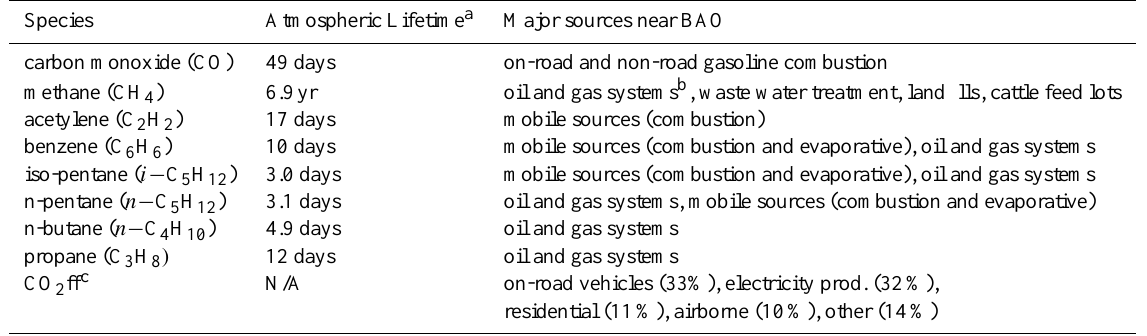
Table 2. Summary of trace gas lifetimes and major emission sources influencing observations at BAO (Watson et al., 2001; Pétron et al.,